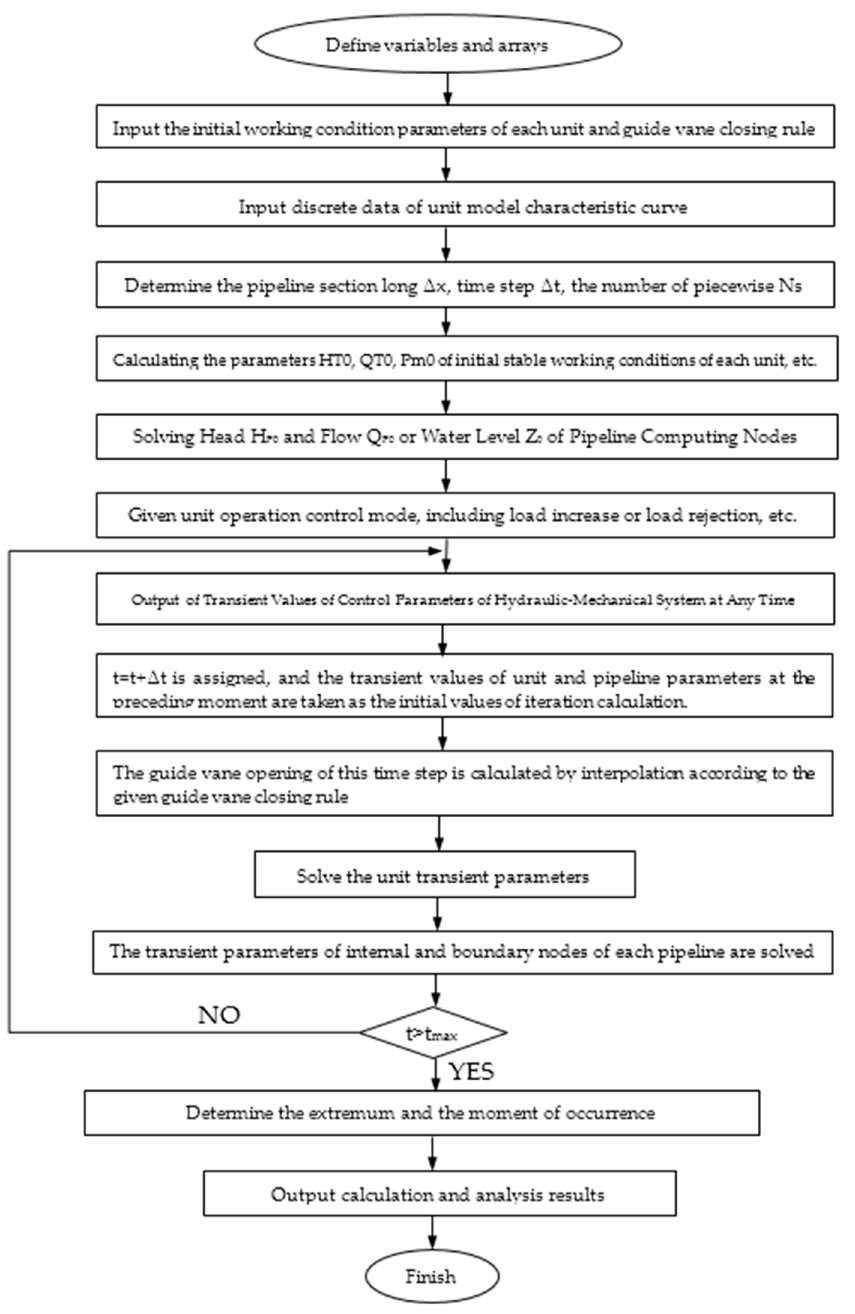
Figure 4. Computational flow chart .